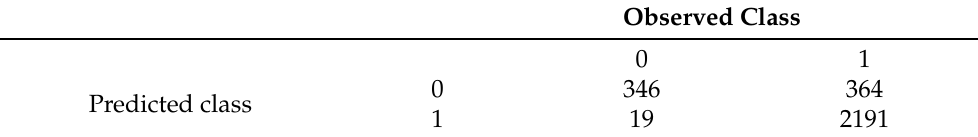
Figure 9. Result of the calibration process for the one-class SVM model with 5-folds cross-validation. Table 9. Confusion matrix for the SVM model on the test set in the one-class classification problem.